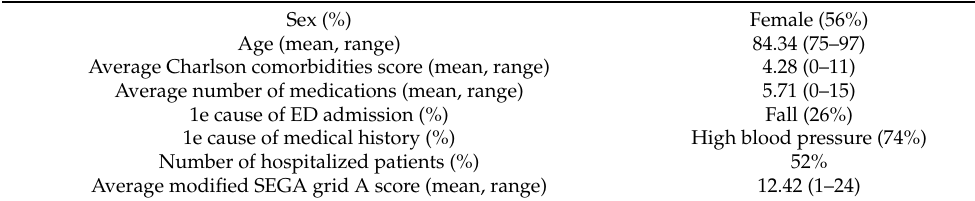
Table 1. Baseline characteristics of the study population ( n =